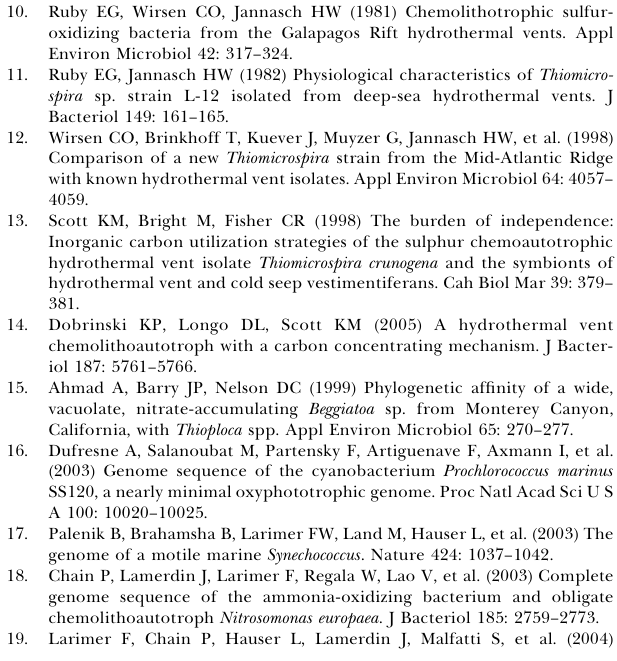
Figure S1. Phylogenetic Relationships of SoxC Sequences of Thiom. crunogena XCL-2 with SoxC/SorA Sequences of Selected Bacteria Sequences were aligned using the program package MacVector. Neighbor-joining and parsimony trees based on the predicted amino acid sequences were calculated using PAUP 4.0b10. At the base of the three main groups, bootstrap values (1,000 replicates) are given for the neighbor-joining (first value) and parsimony analyses (second value). Bootstrapvaluesaredepictedonlyatthebaseofthethreemaingroups. Arabidopsisthaliana representsaplantassimilativenitratereductaseand Drosophila melanogaster represents a eukaryotic sulfite oxidase. Found at DOI: 10.1371/journal.pbio.0040383.sg001 (759 KB TIF). Figure S2. Phylogenetic Relationships of PhnJ Sequences of Thiom. crunogena with PhnJ Sequences of Selected Bacteria Sequences were aligned using the program package MacVector. Neighbor-joining and parsimony trees based on the predicted amino acid sequences were calculated using PAUP 4.0b10. Bootstrap values (1,000 replicates; neighbor-joining/parsimony analyses) are depicted only at the base of the three main groups and for the branch grouping Thiob. denitrificans and Thiom. crunogena. Found at DOI: 10.1371/journal.pbio.0040383.sg002 (892 KB TIF). Protocol S1. Nitrogen Uptake and Assimilation Found at DOI: 10.1371/journal.pbio.0040383.sd001 (49 KB DOC). Table S1. Proteins with a Heme-Coordinating Motif (CxxCH) Found at DOI: 10.1371/journal.pbio.0040383.st001 (49 KB DOC). Table S2. Growth of Thiom. crunogena XCL-2 on Solid Artificial Seawater Medium Supplemented with Carbon and Electron Sources Found at DOI: 10.1371/journal.pbio.0040383.st002 (31 KB DOC). Table S3. Thiom. crunogena XCL-2 RubisCO Activity When Grown in the Presence and Absence of Organic Carbon Found at DOI: 10.1371/journal.pbio.0040383.st003 (28 KB DOC). Table S4. Percent Similarities and Identities of Proteobacterial cbbL, cbbM, and cbbP Genes Found at DOI: 10.1371/journal.pbio.0040383.st004 (80 KB DOC).